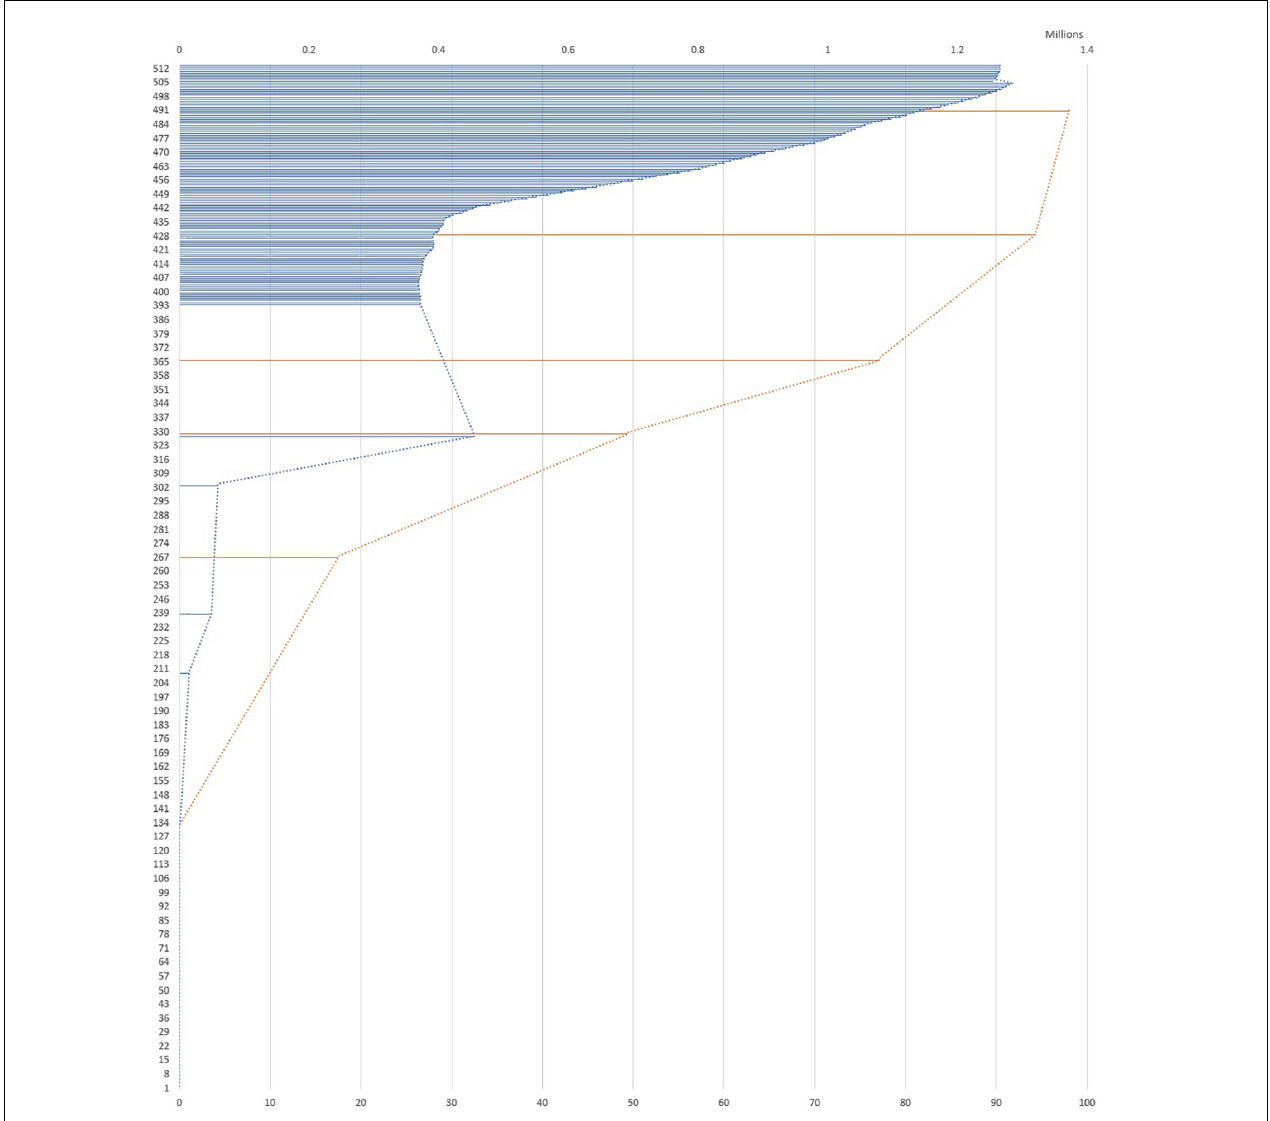
FIGURE 7 | Model aligning human population growth (blue line, millions of people) with forest loss (red line, percent of forest loss). Source data for population development of Mauritius since 1900 are from Statistics Mauritius (https://statsmauritius.govmu.org/SitePages/Index.aspx https://statsmauritius.govmu.org/ SitePages/Index.aspx) and from and United Nations Demographic Yearbook (https://unstats.un.org/unsd/demographic/products/dyb/default.htm). Figures up to 1945 are for the island of Mauritius only. The island of Rodrigues is included thereafter. Figures prior to 1900 were retrieved from Norder et al., 2017. Forest clearance data: based on Norder et al., 2017: forest clearance is derived from forest cover in six historical maps from 1638 onward [See Figure 2 in Norder et al. (2017)]. Timeline is represented on the Y -axis, where Year 1 corresponds to CE 1507 corresponding to the first possible landing on the Island by the Portuguese, and Year 514 is CE